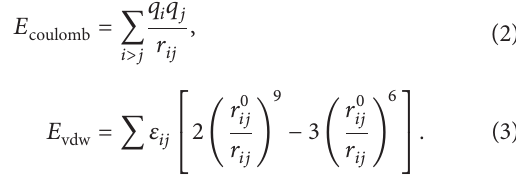
vdw , respectively.